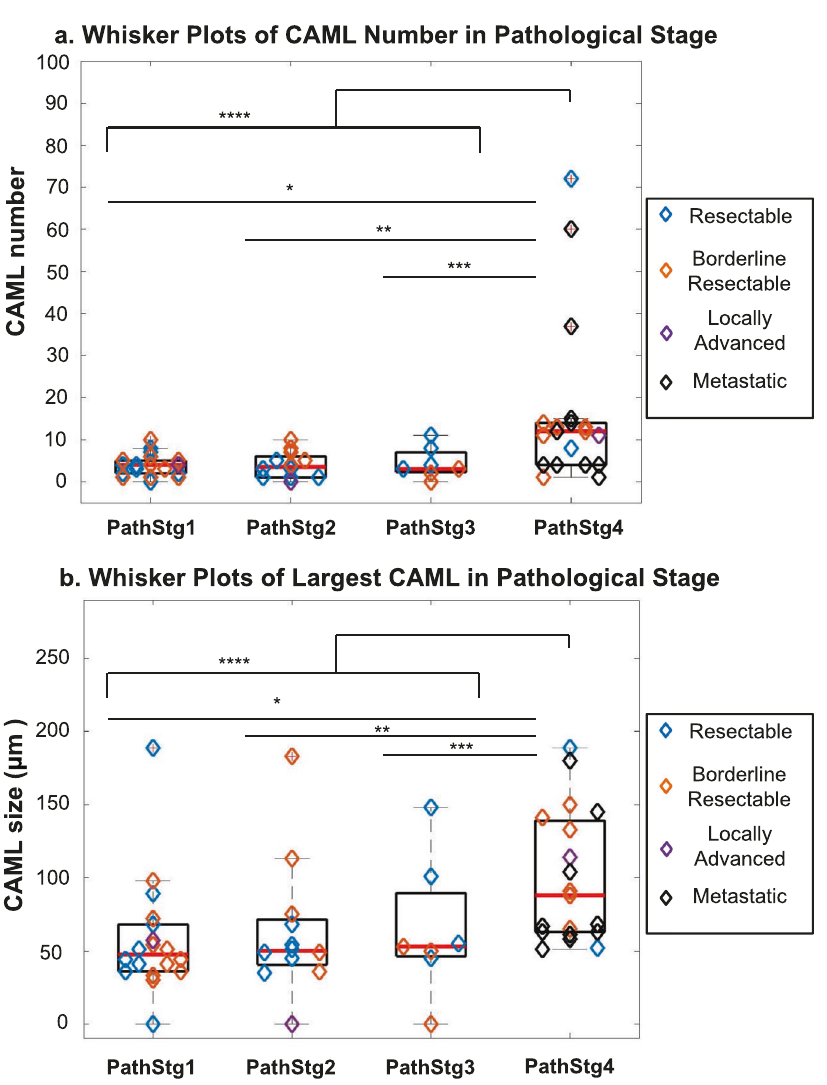
Fig. 3 CAML number and Largest CAML size based of Resectability and Pathological stage. a Number of CAMLs found in patient baseline blood samples based on Pathological Stage and their original Resectability. Whisker Plots of CAML number based on Pathological Stage (median = red line). Wilcoxon ranked sum test of CAML number Stage 1 vs Stage 4 * p = 0.001, Stage 2 vs Stage 4 ** p = 0.003, Stage 3 vs Stage 4 *** p = 0.015, and nonmetastatic vs metastatic disease **** p < 0.001. b Largest CAML found in patient baseline blood samples based on Pathological Stage and their original Resectability. Whisker Plots of CAML size based on Pathological Stage (median = red line). Wilcoxon ranked sum of CAML size Stage 1 vs Stage 4 * p < 0.001, Stage 2 vs Stage 4 ** p = 0.010, Stage 3 vs Stage 4 *** p = 0.043 and nonmetastatic vs metastatic disease **** p <